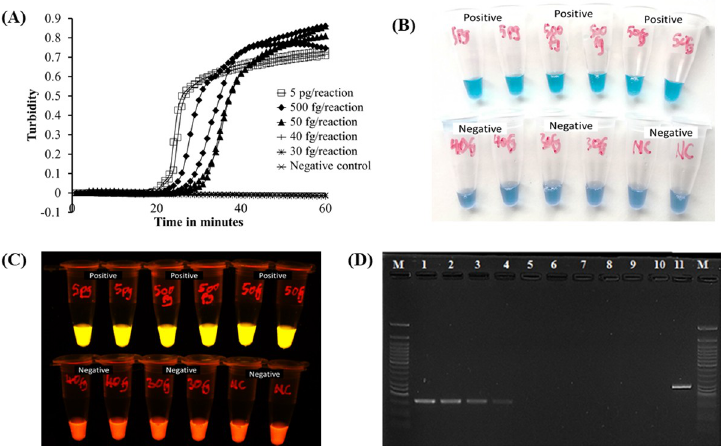
Fig 2. Sensitivity of established LAMP assay and multiplex PCR. A) LAMP results observed by rising curves of turbidimeter. B) LAMP results observed by the naked eye under natural light; the colour shifts from violet to sky blue for positive samples. C) Under LED light, the color change is from orange to light yellow for positive samples. D) The gel electrophoresis result of the multiplex PCR [16]. Lane M, 50bp DNA marker (New England Biolabs); lanes 1–9, M